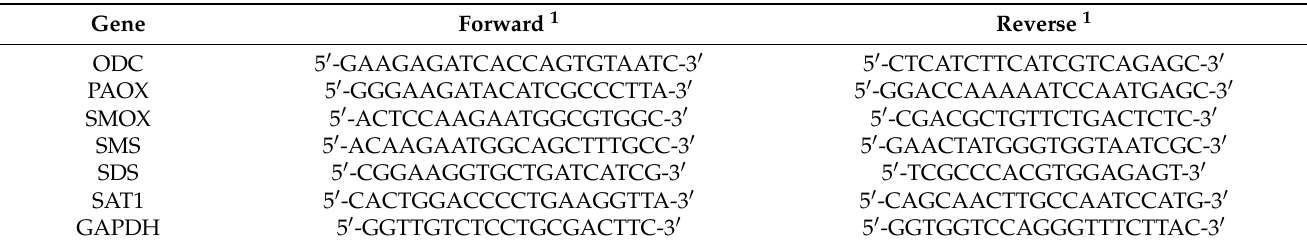
Table 1. Primers used for the